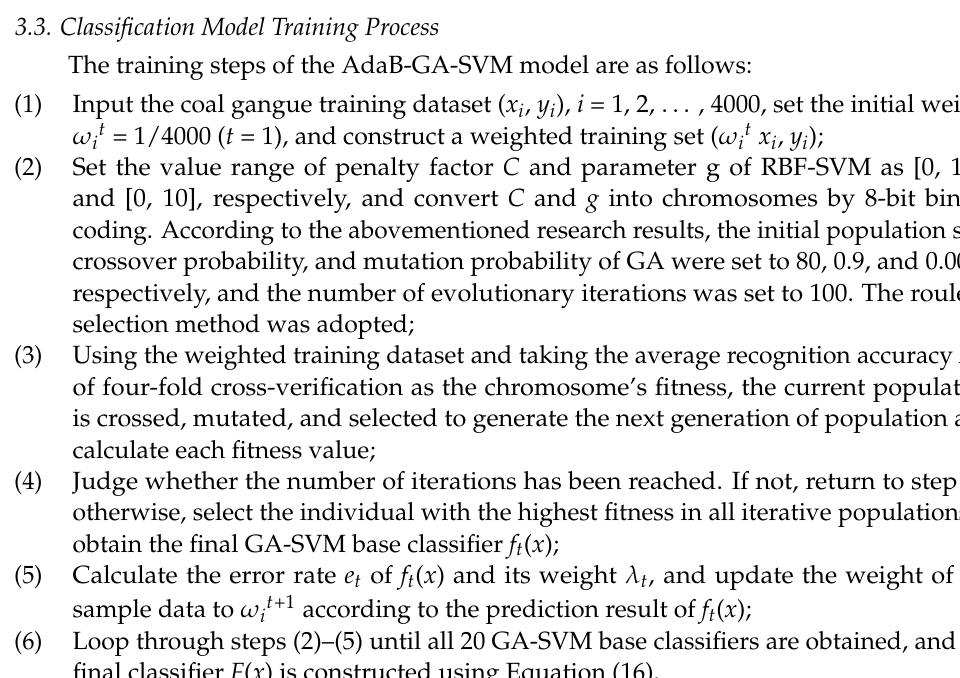
Figure 6. Importance of the texture features of the coal gangue image [33].